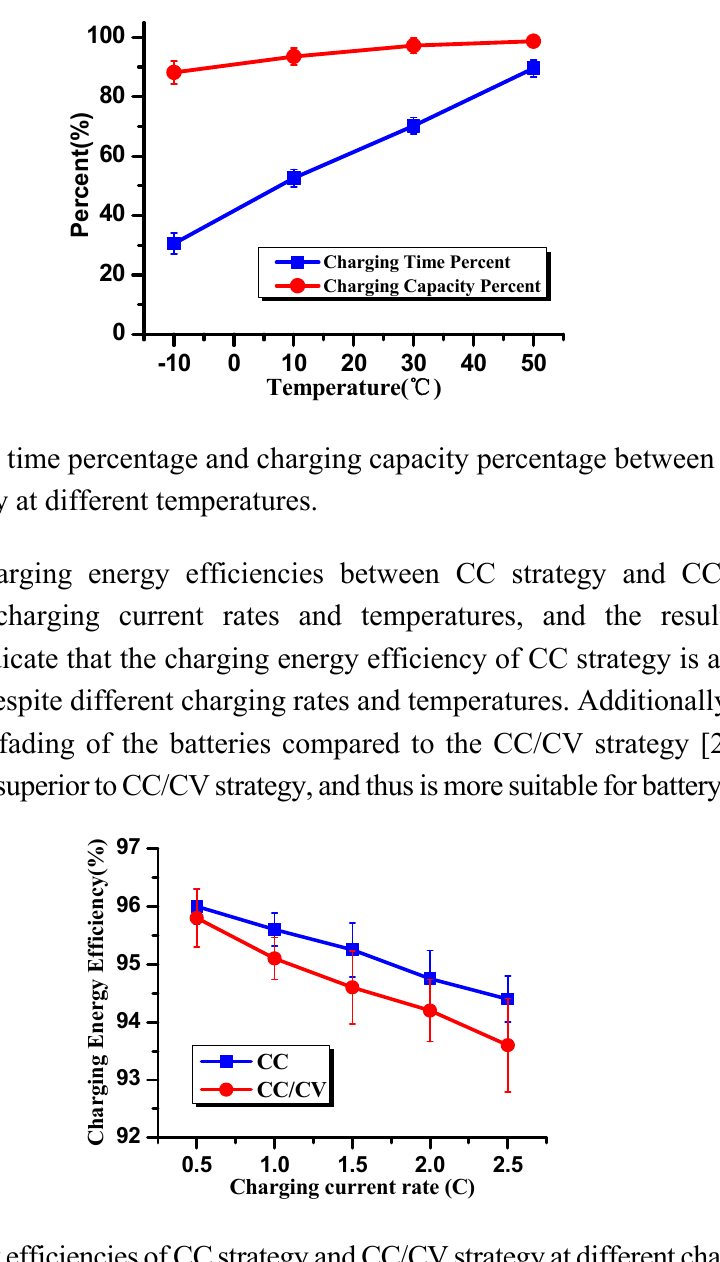
Figure 5. Charging energy efficiencies of CC strategy and CC/CV strategy at different charging current